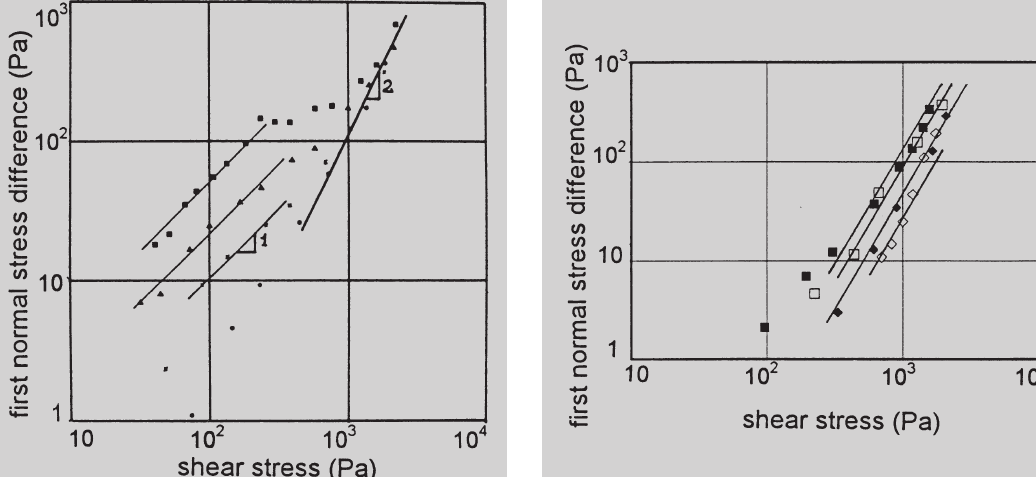
Figure 5 (left): Dependence of the normal stress on shear stress of suspensions with the silicone oil M 20000 and different concentrations of Cab-o-sil TS 720 ( ‡ 1%, · 3%, Ï 5%, Ì 7%) and silicone oil M20000 ( Ú ). Figure 6 (right): Dependence of the normal stress on shear stress of disperse systems with the silicone oil M20000 and different concentrations of Durcal 5 ( · 25%, Ï 32.75%, Ì 40.5%) and of silicone oil M20000 ( ‡